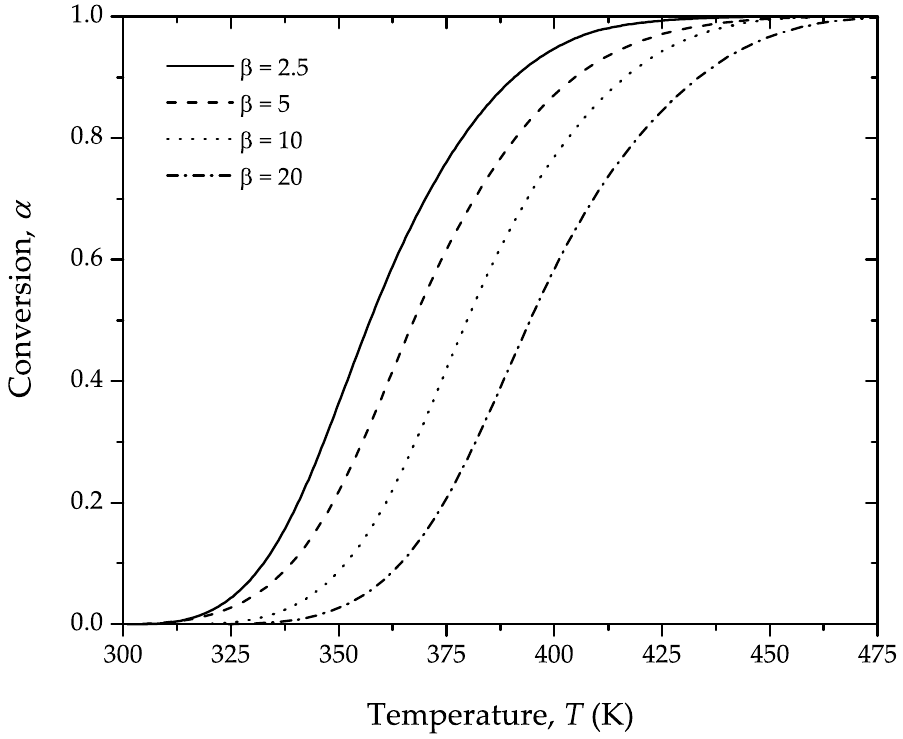
Figure 3. Fractional conversion of the curing of a partially bio-based epoxy resin as a function of temperature for different heating rates, β .